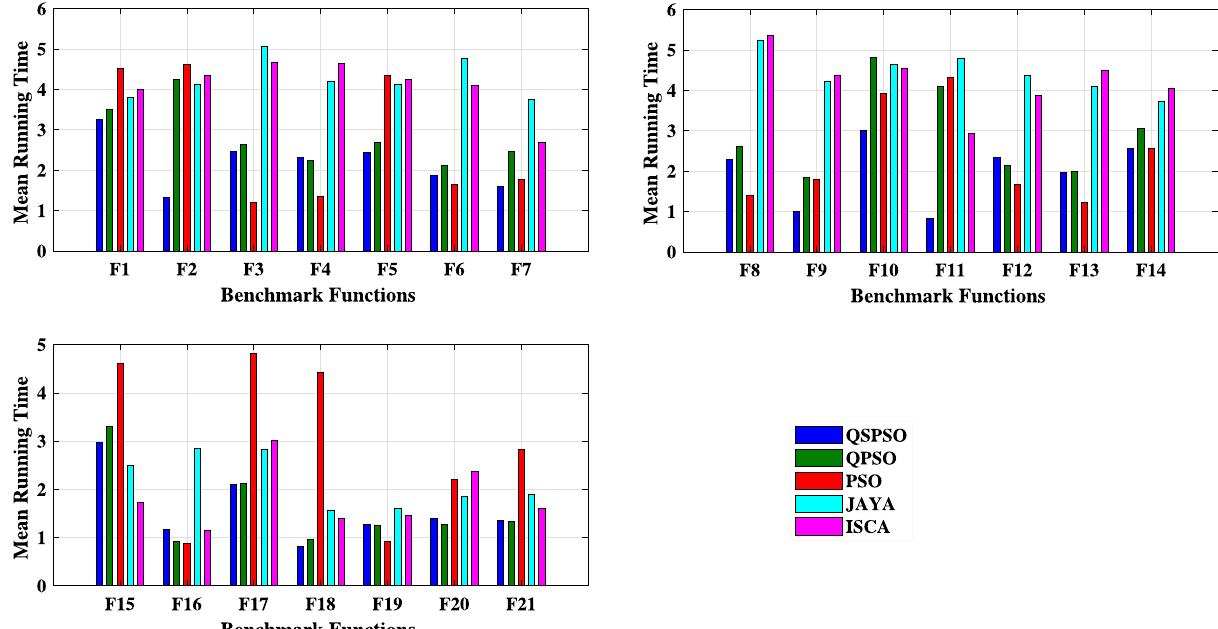
Figure 8. The average running time for optimization algorithms on the test functions. (For each test function, the bar graphs belong to QSPSO, QPSO, PSO, JAYA, and ISCA from left to right,